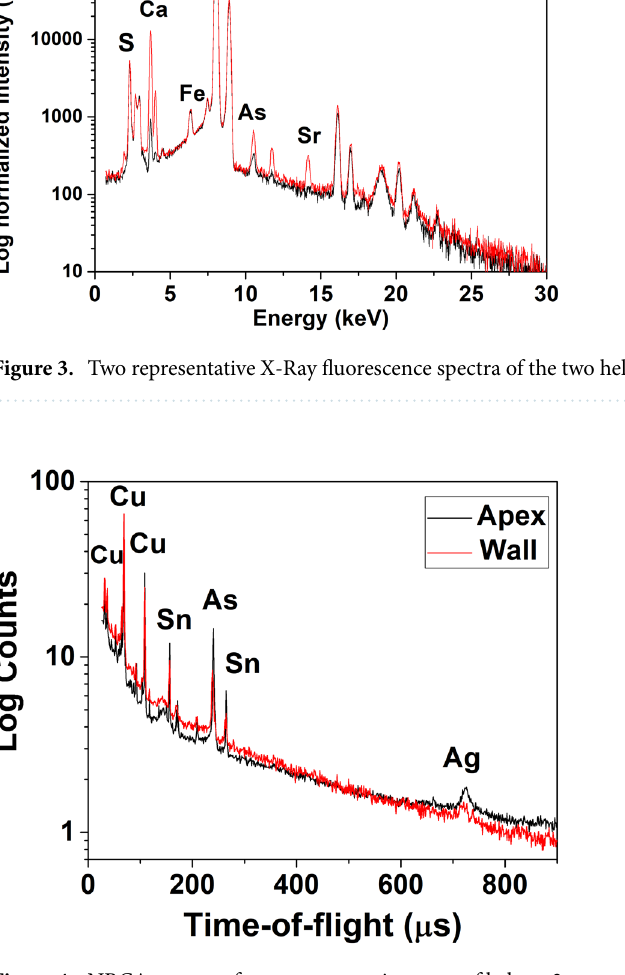
Figure 4. NRCA spectra of two representative spots of helmet